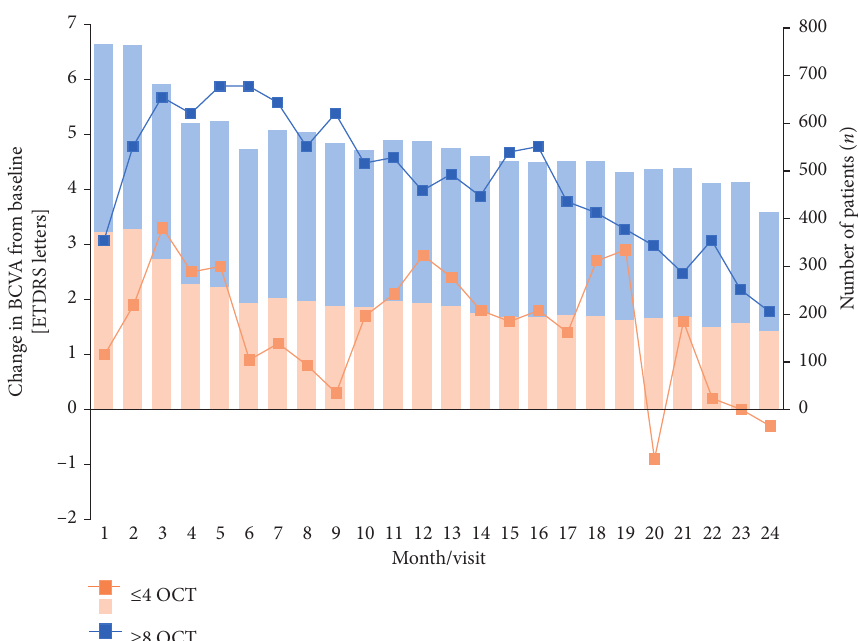
Figure 4: Changes in BCVA from baseline in ETDRS letters for patients receiving ≤ 4 OCTexaminations or ≥ 8 OCTexaminations. BCVA: best-corrected visual acuity; ETDRS: Early Treatment for Diabetic Retinopathy Study; OCT: optical coherence